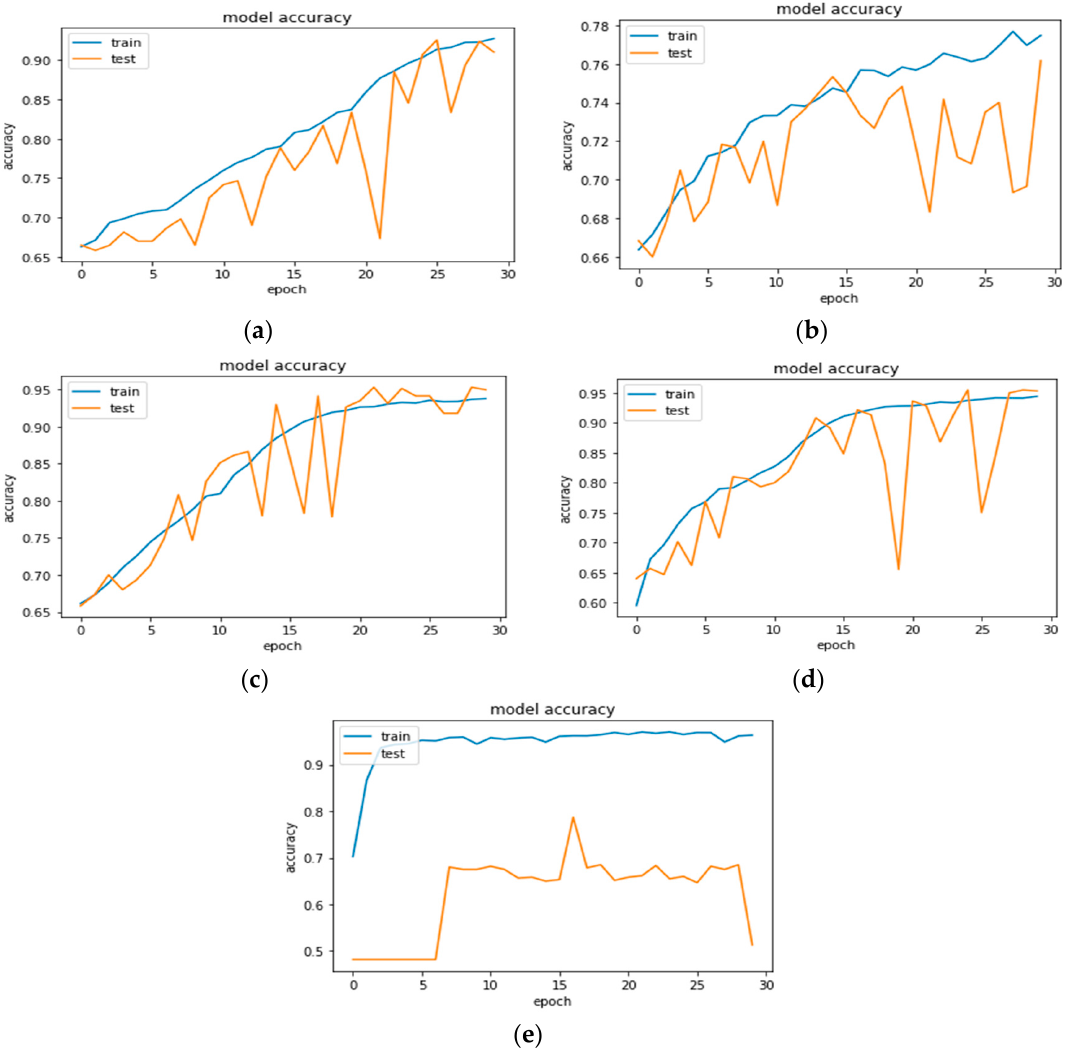
Figure 10. Plots of accuracy models for ( a ) 1-CNN, ( b ) 2-CNN, ( c ) 3-CNN, ( d ) 4-CNN, and ( e ) Transfer learning with ResNet50.